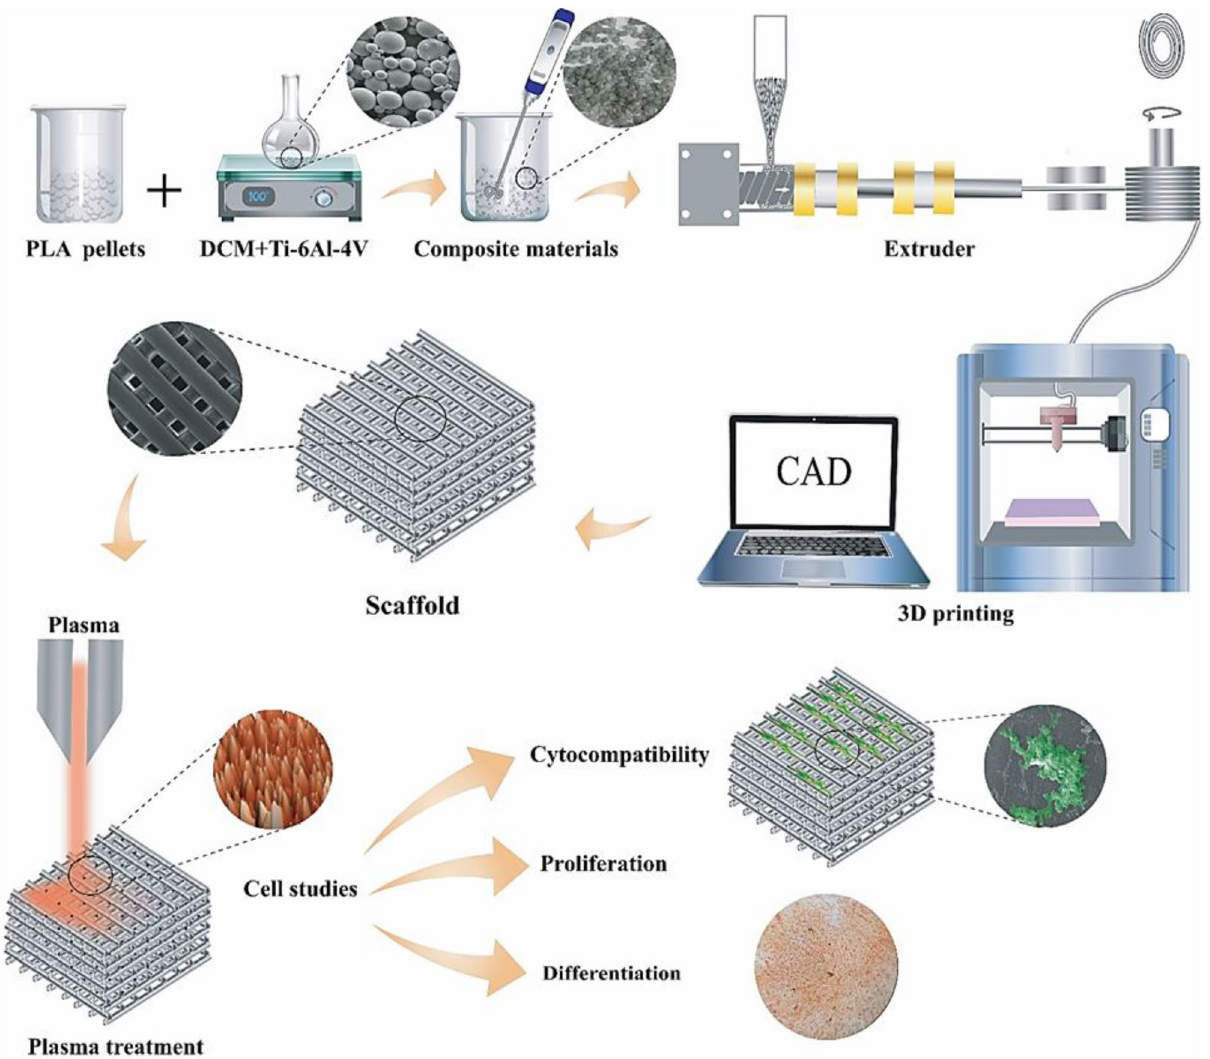
Figure 1. Schematic illustration of the method used to fabricate 3D porous PLA/Ti64 composite